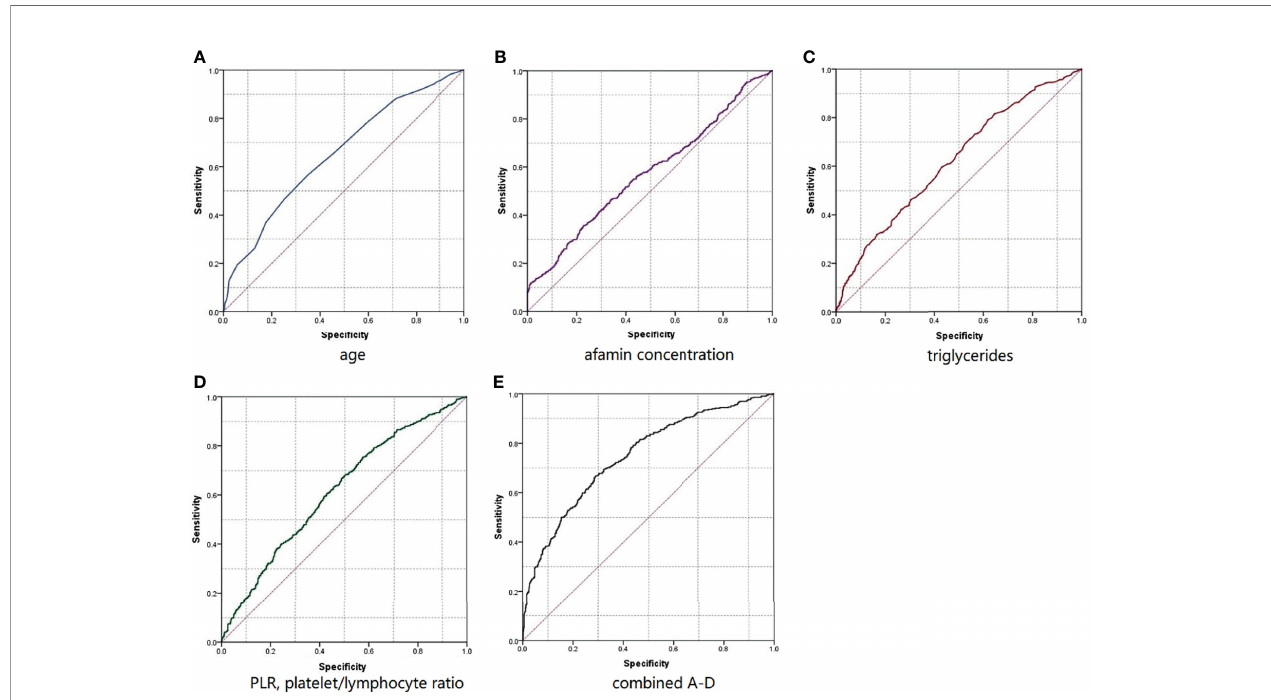
FIGURE 2 | RoC curves predicted individually (A – D) or combined (E) using age (A) , afamin concentration (B) , triglyceride (C) , and platelet lymphocyte ratio (D) levels in the early stages of